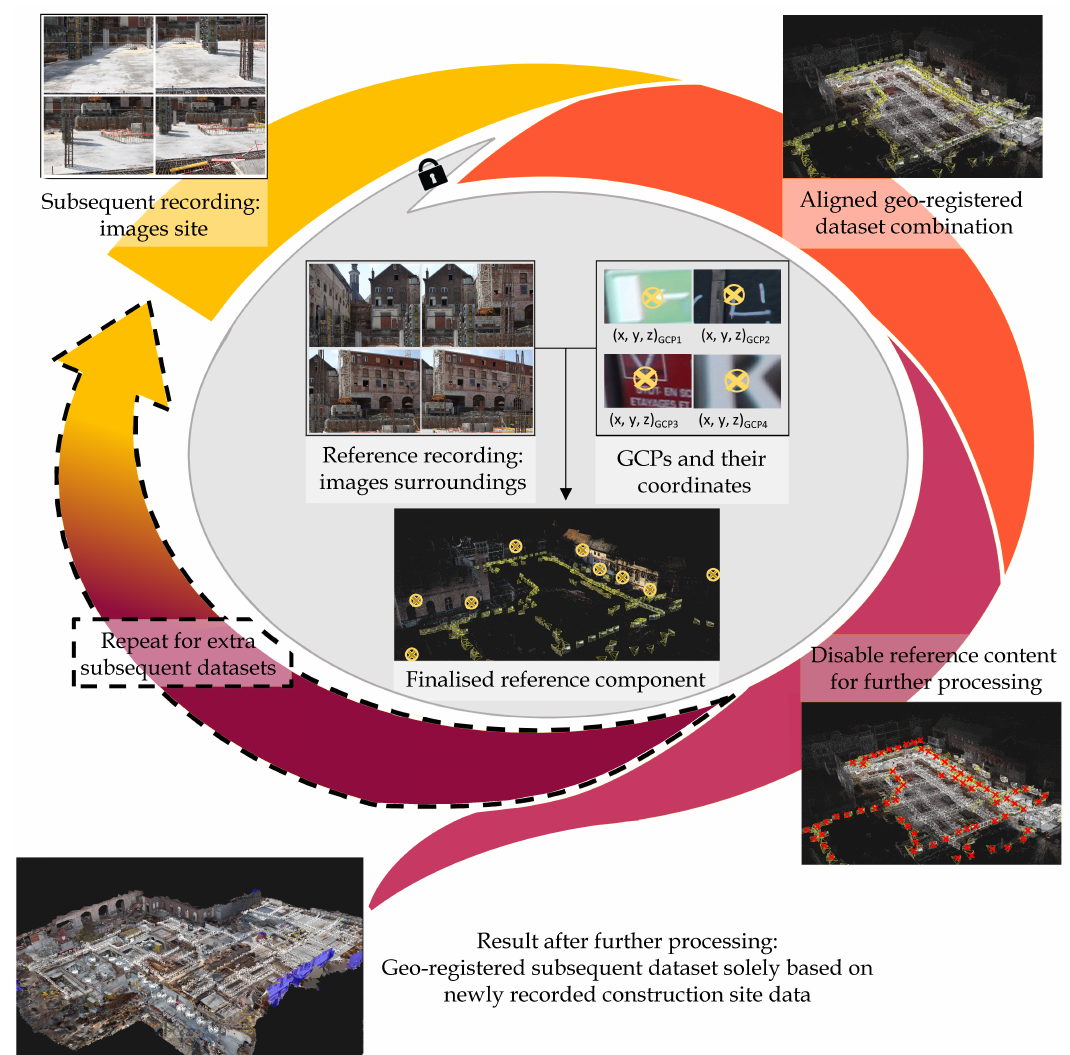
Figure 3. The central part of the methodology diagram depicts the reference component creation process. This module is then locked and serves repeatedly as crucial input for the processing of subsequent datasets, as depicted in the outer